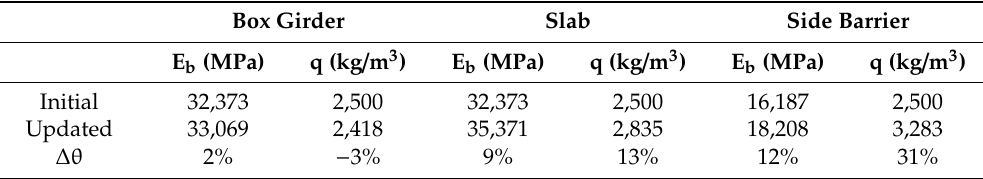
Table 4. Values of the initial and updated parameters θ .